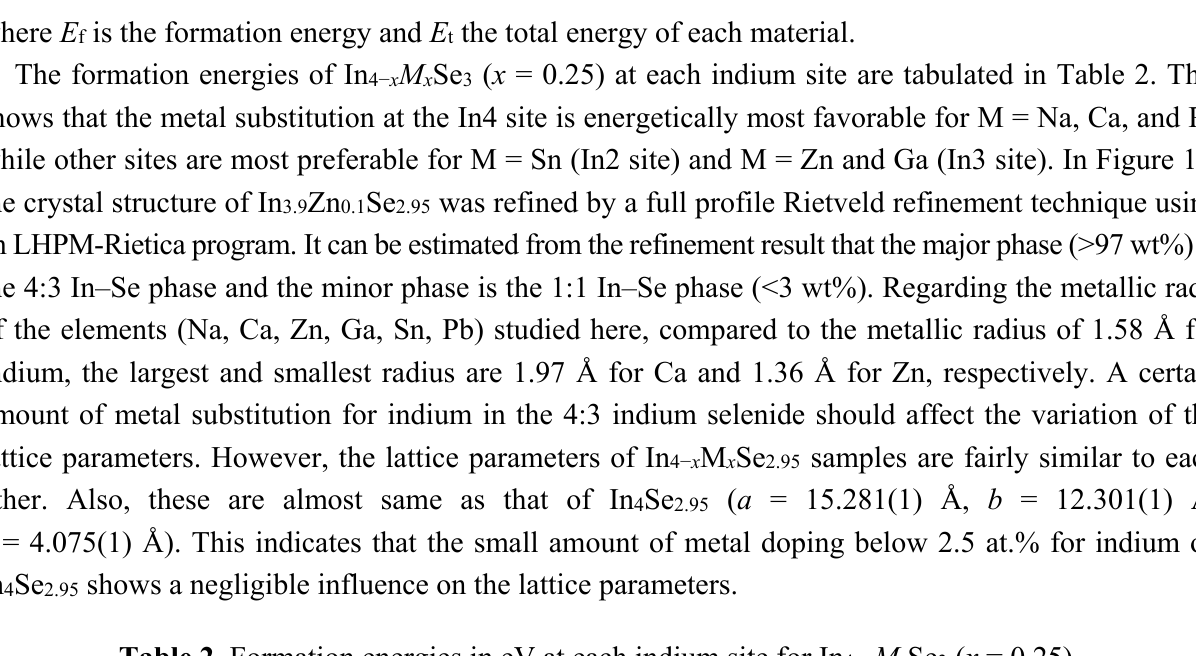
Table 2. Formation energies in eV at each indium site for In 4 − x M x Se 3 ( x =